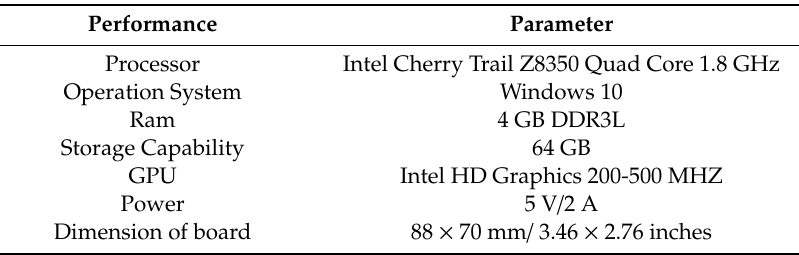
Table 3. The performance parameter of